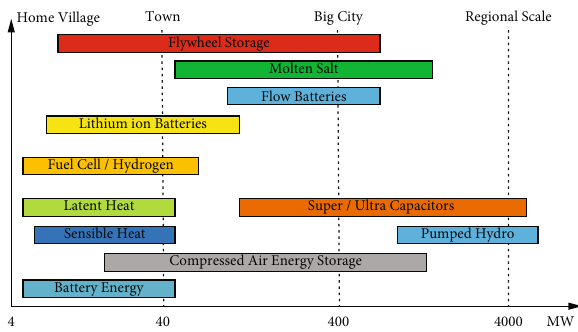
Figure 3: Energy storage technology capacity and preferred installation